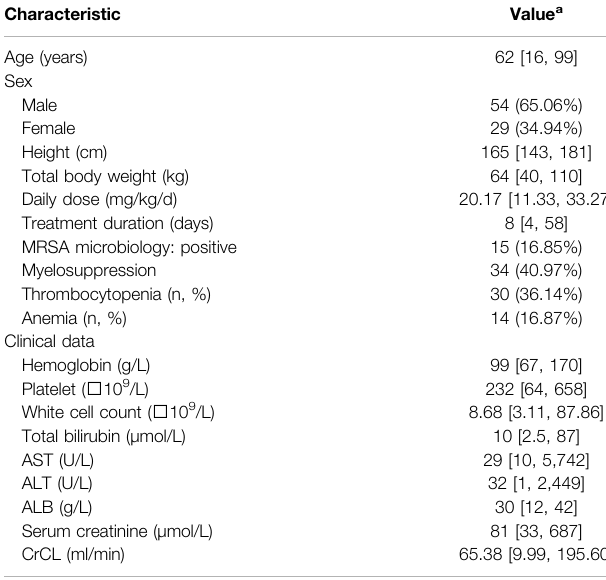
TABLE 1 | Baseline characteristics of patients included for pharmacokinetic analysis set or hematological toxicity analysis set.